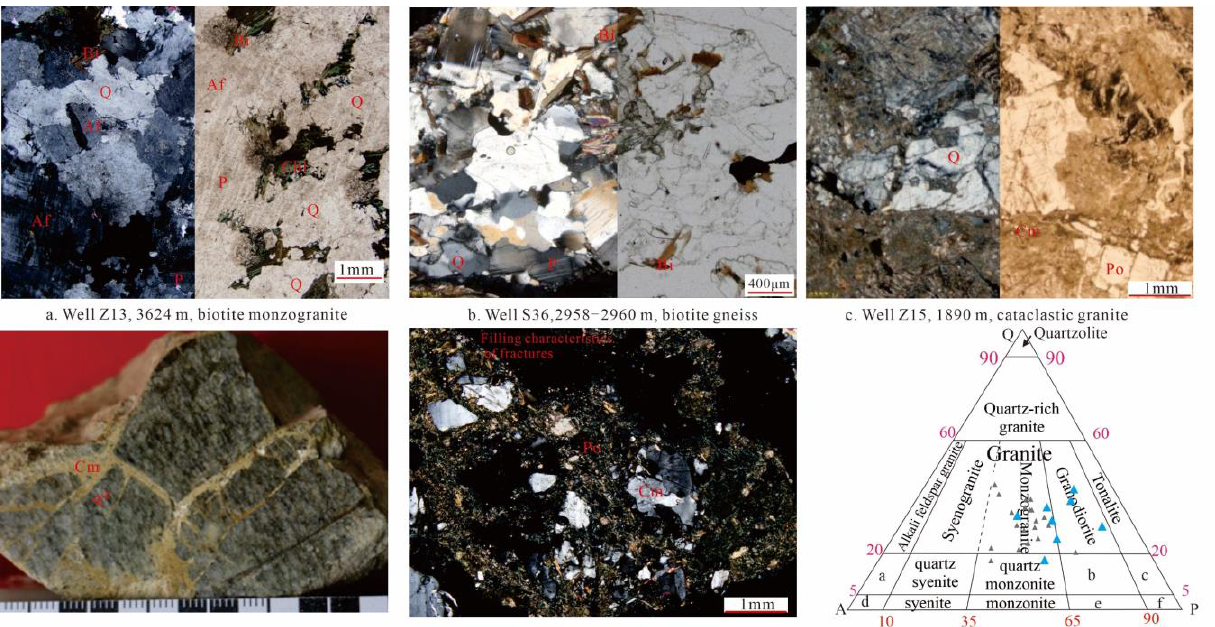
Figure 2. Types of basement rocks in the LS depression in the ECSB. Note: Af—Alkali feldspar, Bi—